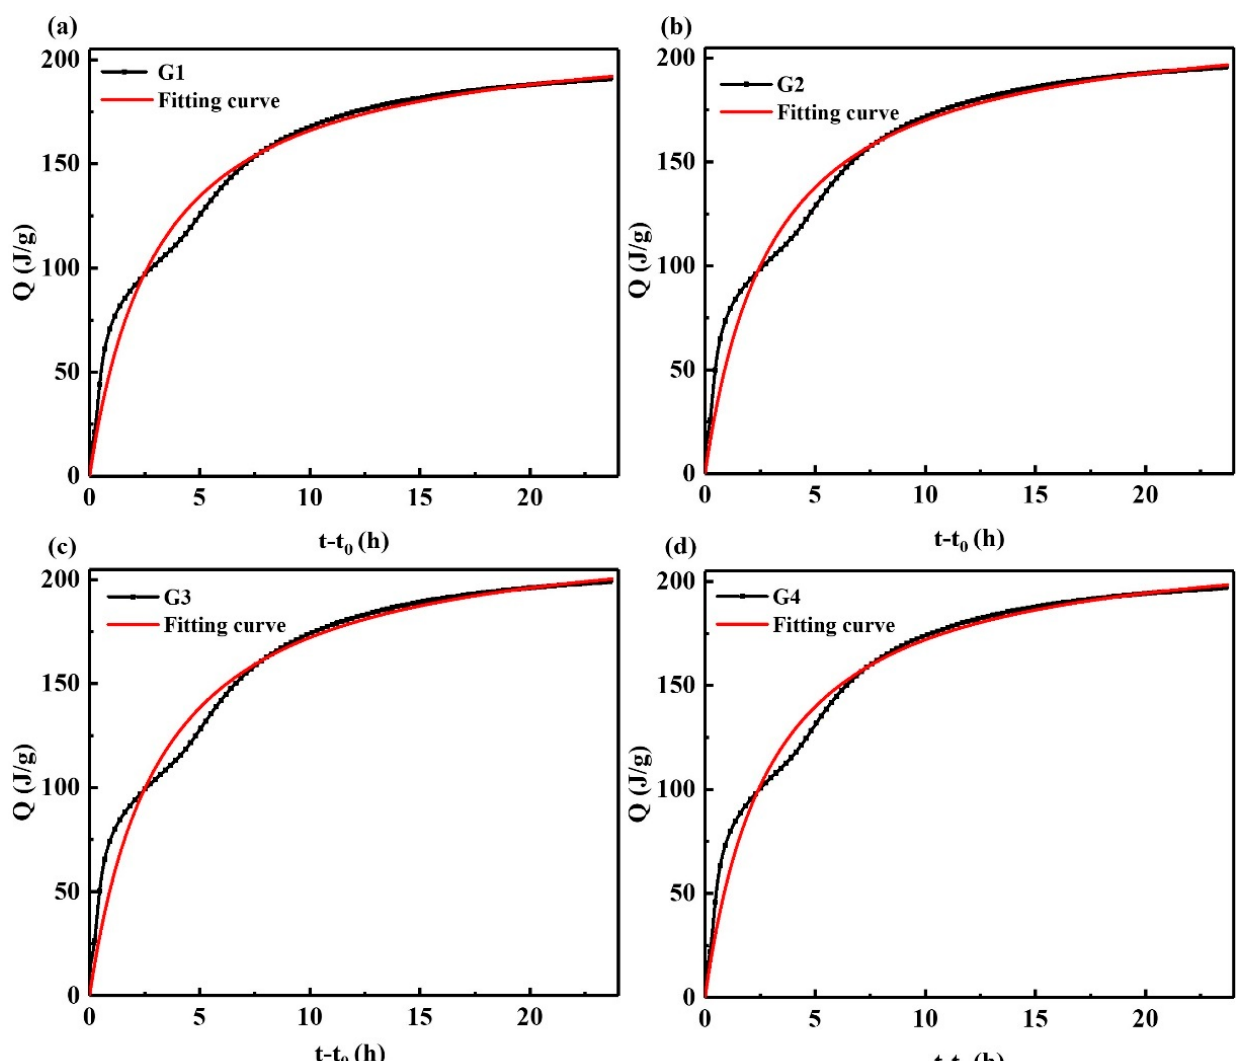
max ; ( a ) G1, ( b ) G2, ( c ) G3, ( d ) G4.